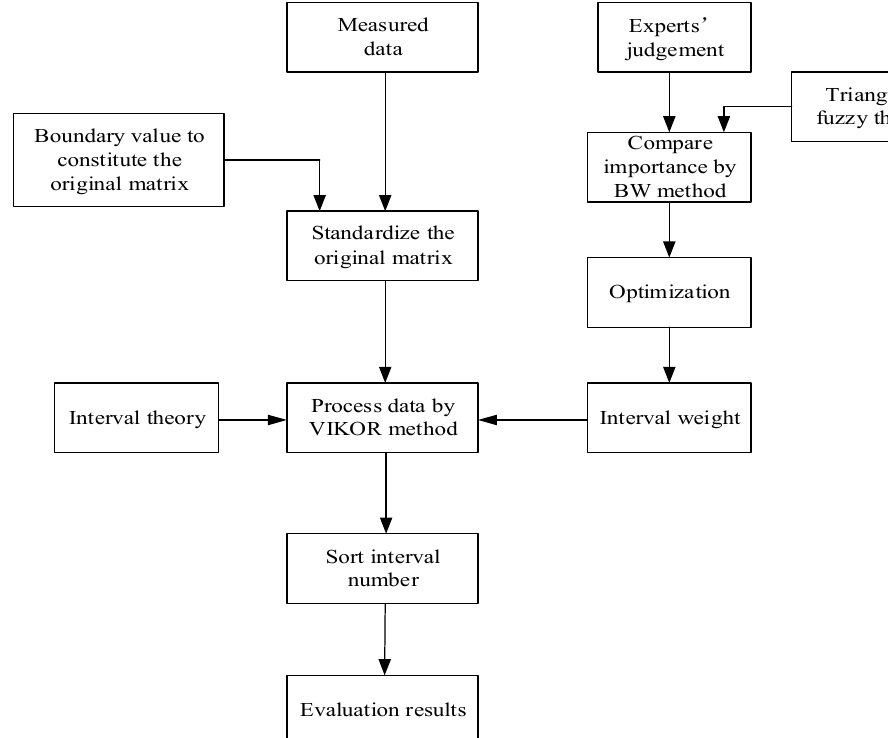
Figure 5. The flow chart of the steady-state power quality evaluation.